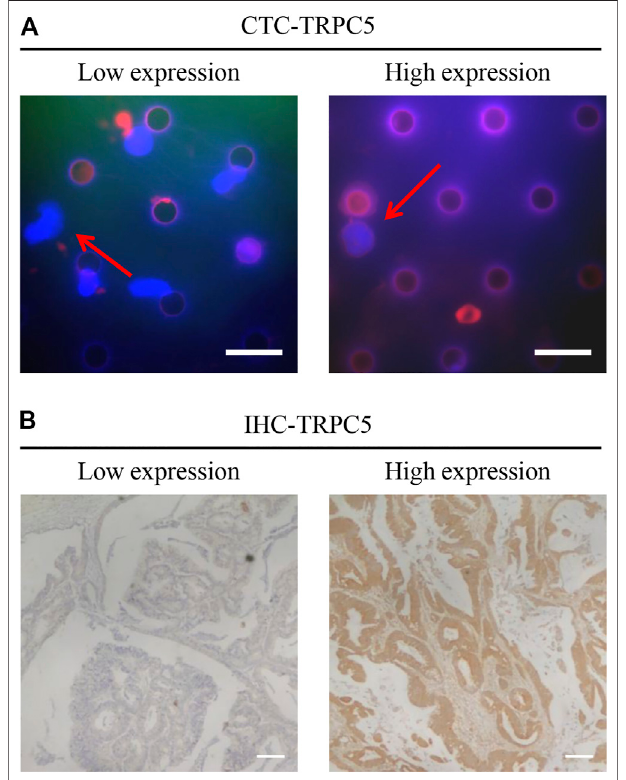
FIGURE 1 | (A) Representative images of the immunohistochemical staining of CTC-TRPC5 expression (Scale bars, 20 µm). (B) Representative images of the immunohistochemical staining of TRPC5 expression in human CRC tissues (Scale bars, 300 µm).